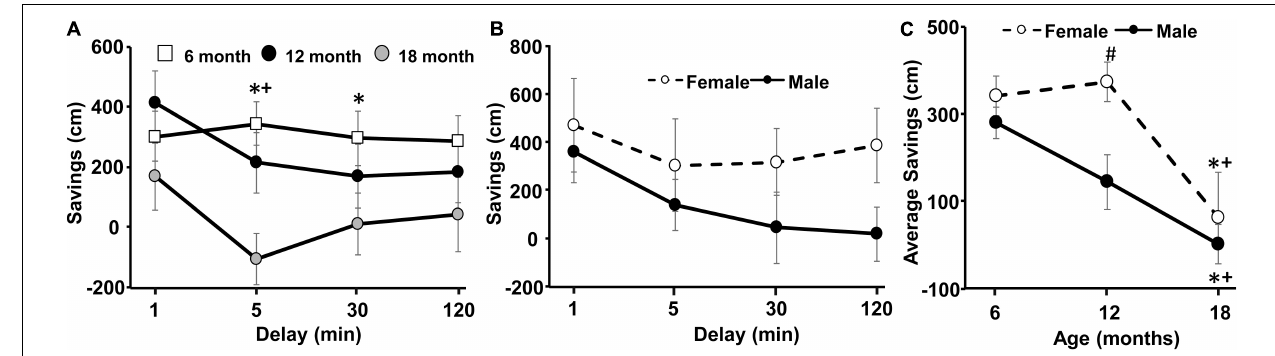
FIGURE 3 | Decline in spatial memory with age. (A) Age- and delay-related decline in savings scores for delays of 1–120 min at the three ages. (B) A sex difference at 12 months was due to better performance by females. (C) Savings scores, averaged across each delay, for each animal, and plotted for the three different ages. Pound sign indicates a significant ( p < 0.05) sex difference at each age. Asterisks indicated a significant ( p < 0.05) difference from 6 months and + sign indicates a significant difference ( p < 0.05) between 12 and 18 months.